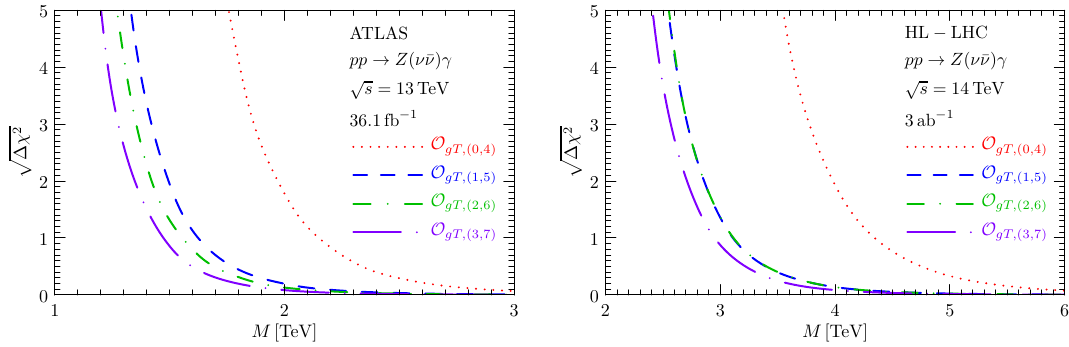
p Figure 6 . The significances ∆ χ 2 for probes of the individual dimension-8 gQGC operators O , where i = 0 , 1 , 2 , 3 , from the Z ( ν ¯ ν ) γ channel as functions of the cut-off scales M i . The gT, ( i,i +4) left panel shows the sensitivities obtained using the current LHC data with luminosity L = 36 . 1 fb − 1 while the right panel shows the estimated sensitivities for the future √ HL-LHC with s = 14 TeV and L = 3 ab − 1